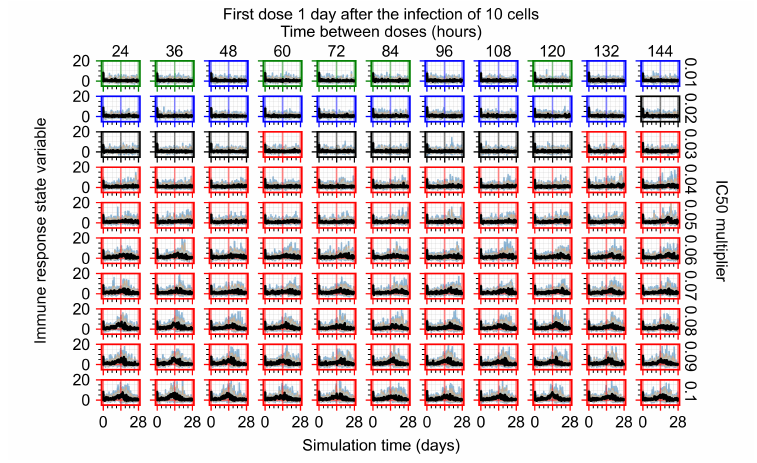
Figure A122. Immune response state variable number. Positive values correspond to an inflammatory state, and negative to an anti-inflammatory state.